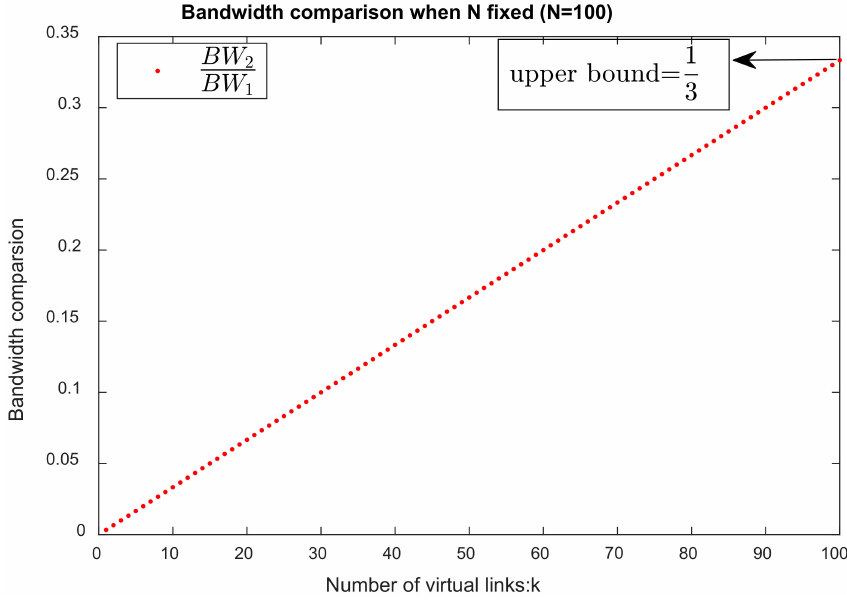
Figure 10. Bandwidth ratio BW 2 increases linearly with the number of virtual BW 1